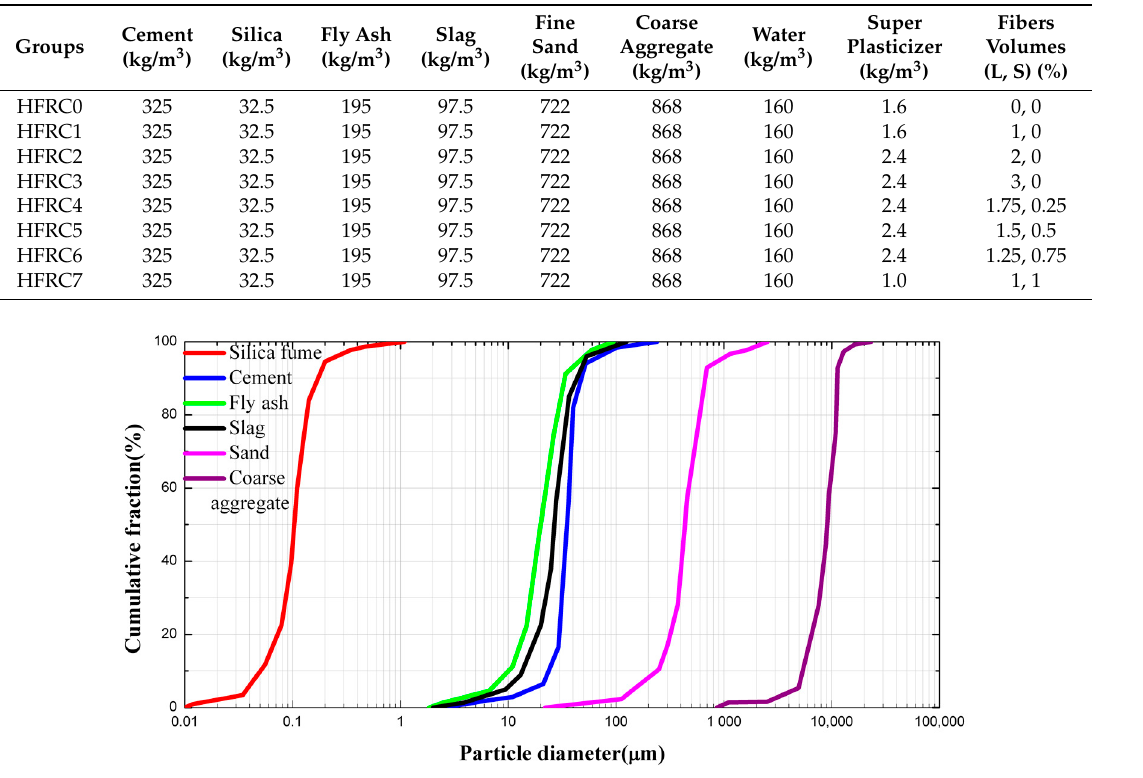
Figure 1. Particle size distribution of the used material. Figure 2. Particle size distribution of the used material. Table 2. Mechanical properties of steel